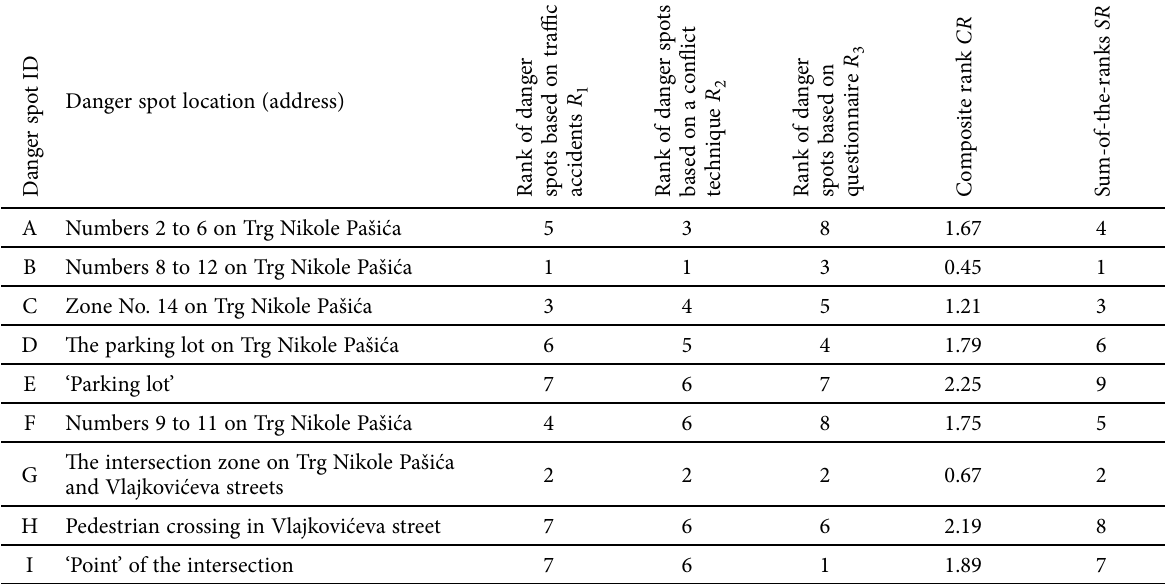
Table 4. Composite ranking of danger spots (Vujanić et al. 2009b)